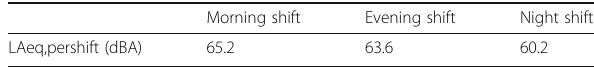
Table 2 (abstract 0212). Continuous equivalent sound pressure (LAeq,pershift) during shifts Morning shift Evening shift Night shift LAeq,pershift (dBA)